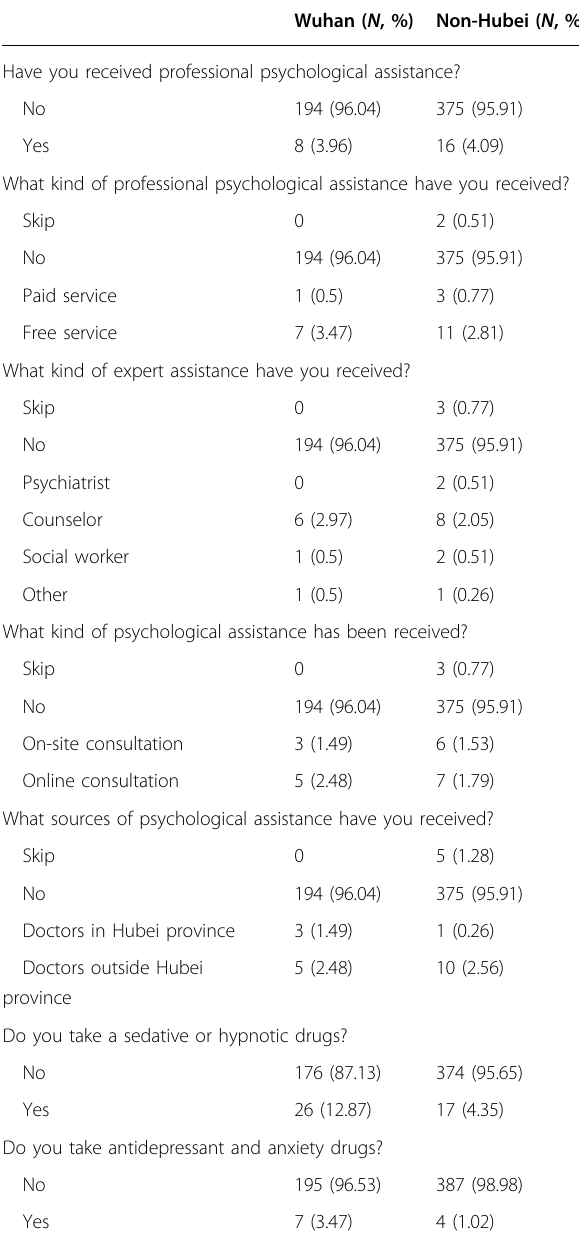
Table 5 Mental health service for nurses.